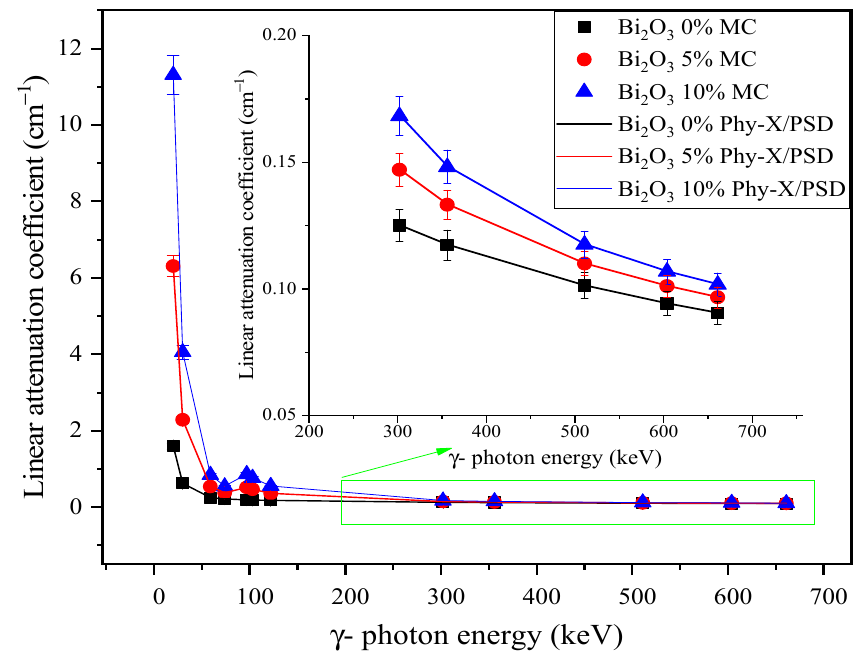
Figure 2. The linear attenuation coefficient of the polyepoxide-reinforced Bi 2 O 3